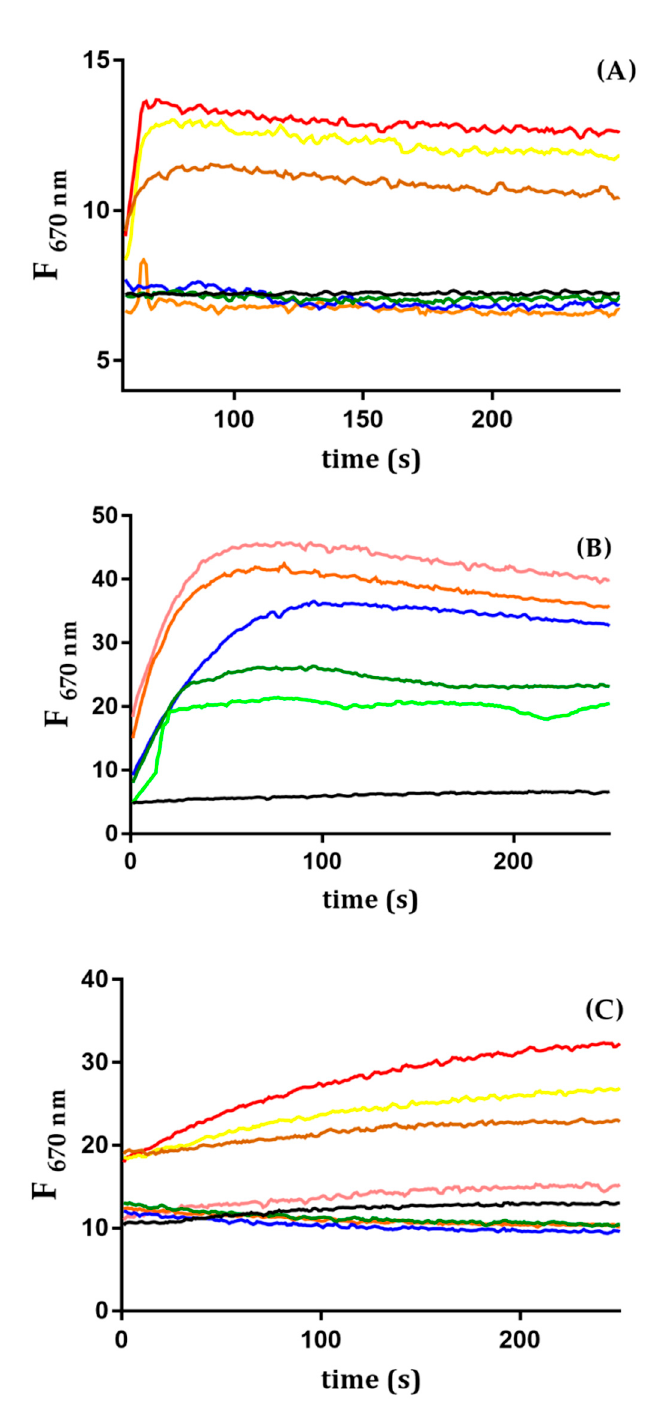
Figure 9. Inner Membrane depolarization measured using Disc3(5): ( A ) Psychrobacter TAD1, ( B ) B. pumilus , ( C ) E. coli at different Trematocine concentrations. For every species, the baseline is in black, then: light green, 10 nM; dark green, 20 nM; blue, 50 nM; orange, 100 nM; pink, 250 nM; brown, 0.5 µM; yellow, 1 µM; and red, 2 µM.